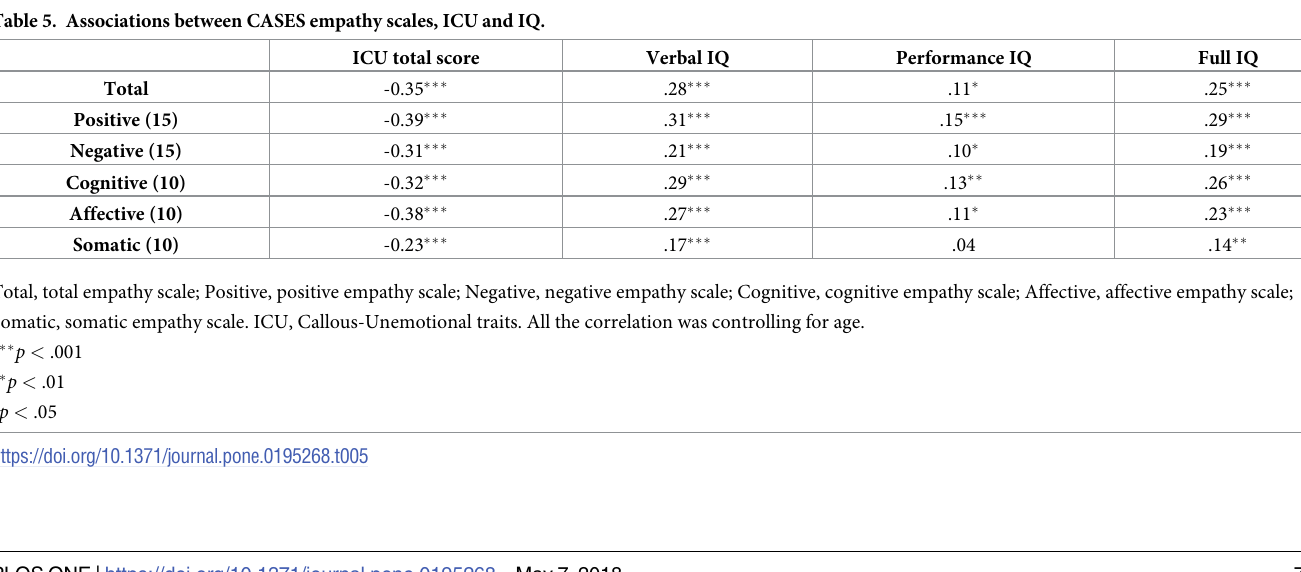
Total, total empathy scale; Positive, positive empathy scale; Negative, negative empathy scale; Cognitive, cognitive empathy scale; Affective, affective empathy scale; Somatic, somatic empathy scale.